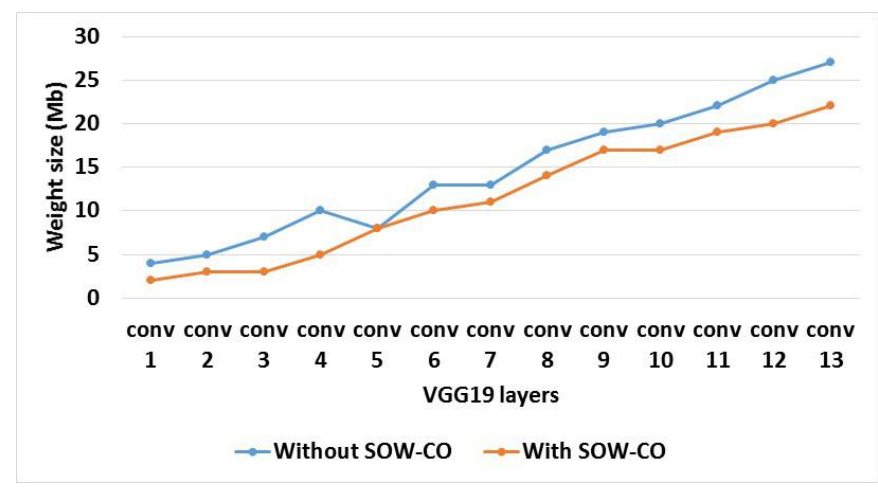
Figure 14. Graphical illustration of weight size for VGG19.